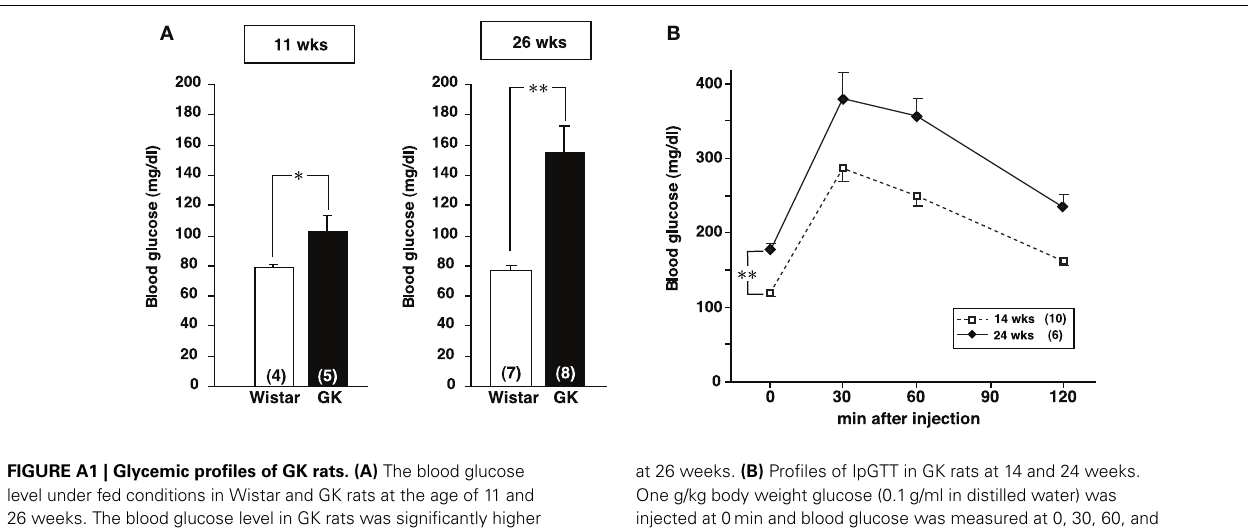
at 26 weeks. (B) Profiles of IpGTT in GK rats at 14 and 24 weeks. One g/kg body weight glucose (0.1g/ml in distilled water) was injected at 0min and blood glucose was measured at 0, 30, 60, and 120min after injection. The glucose intolerance was progressed in GK rats at 24 weeks of age ( ∗∗ p < 0 . 01, Student’s t -test).